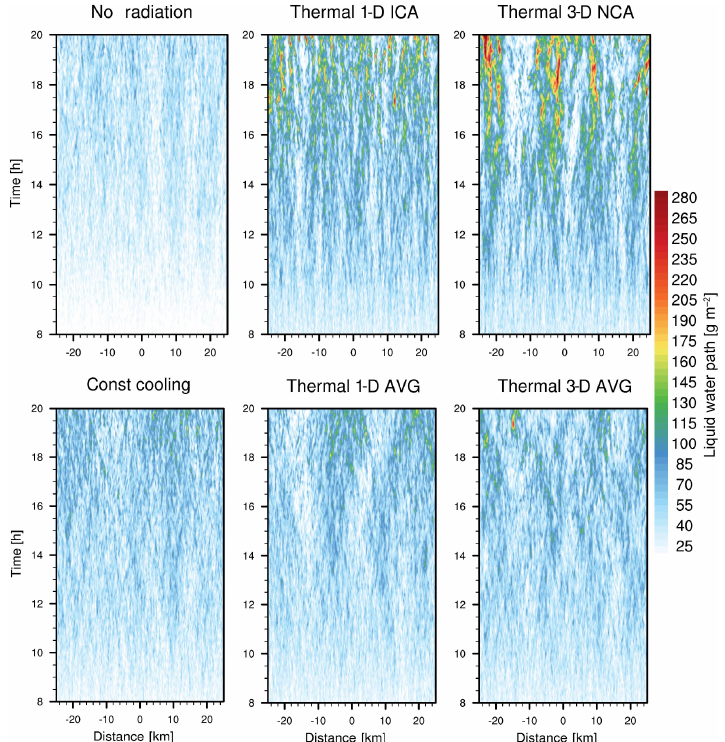
Figure 21. Cloud organization in the 100m resolution simulations shown as Hovmöller diagrams of the liquid water path, averaged in x direction.